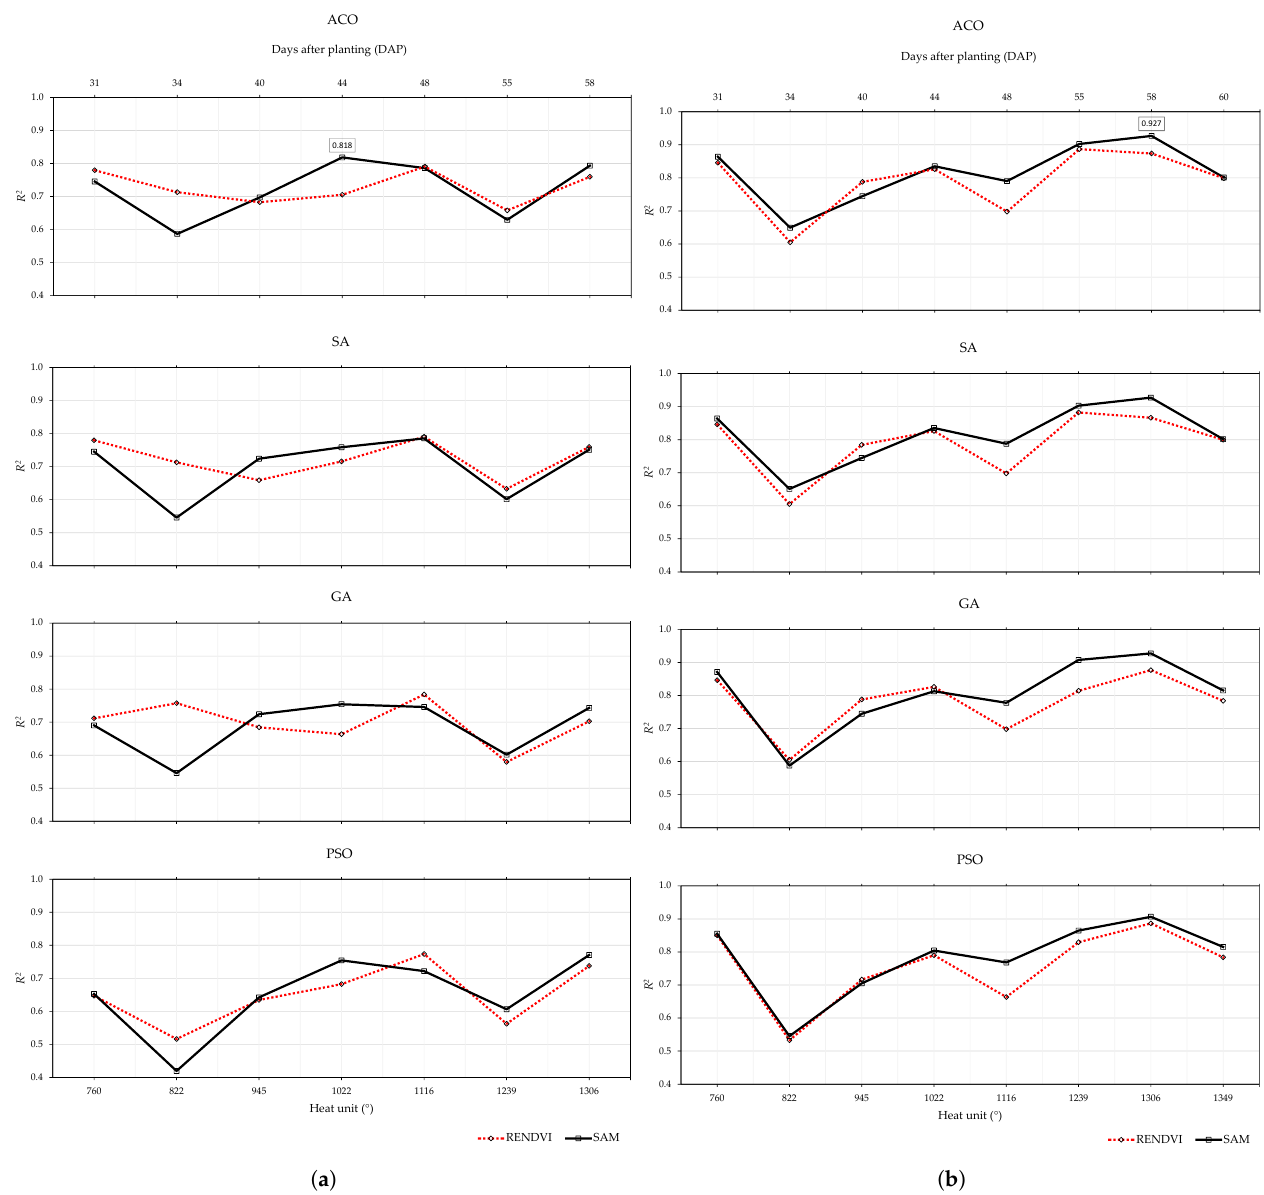
Figure 12. Coefficient of determination ( R 2 ) results for snap bean 2020 pod weight data set, for ( a ) early and ( b ) the late harvest stage via PLSR model and two different vegetation approaches, SAM and